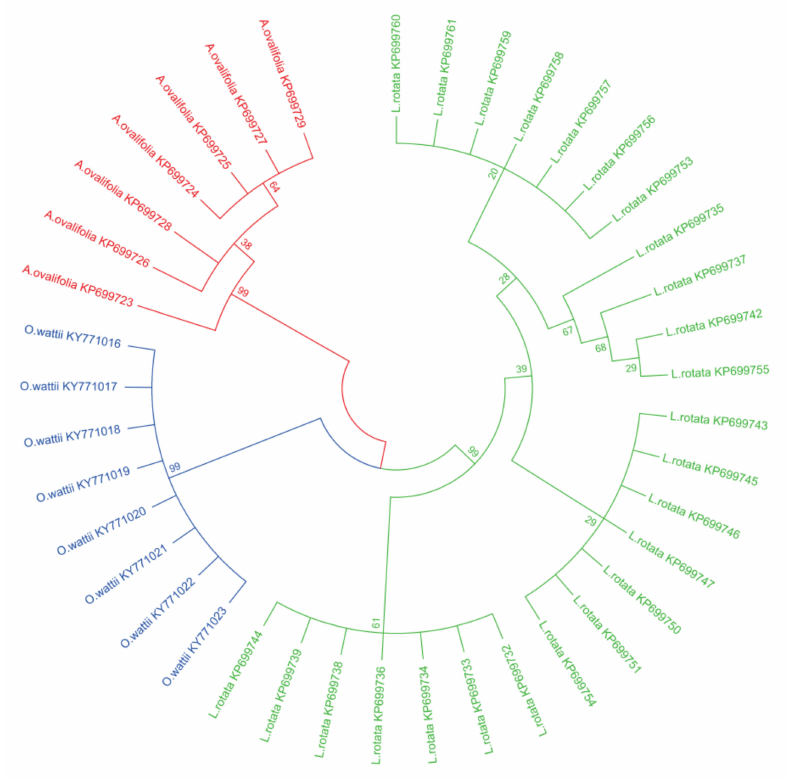
Figure 1. Neighbor-joining trees of L. rotata , A.ovalifolia , and O.wartii by internal transcribed spacer 2 (ITS2). The bootstrap scorers (1000 replicates) are shown ( ≥ 50%) for L. rotata and its